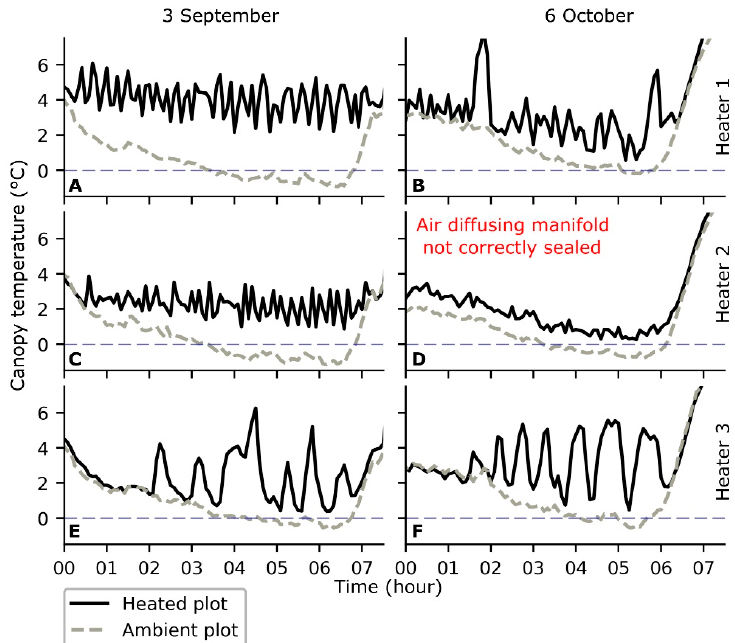
Figure 5. Canopy temperature recorded by thermal infrared Arducrop ® (10 ° FOV) for the heated plot (solid line) and equivalent unheated plot (dashed line) on 3 September 2017 ( A , C , and E ) and